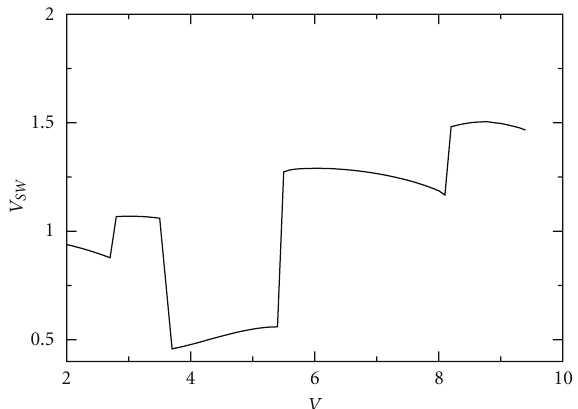
Figure 5: The spin wave velocity of the G -mode as a function of V . Note that it never vanishes, but that it can vary by a factor of three, and have significant discontinuities at transitions.